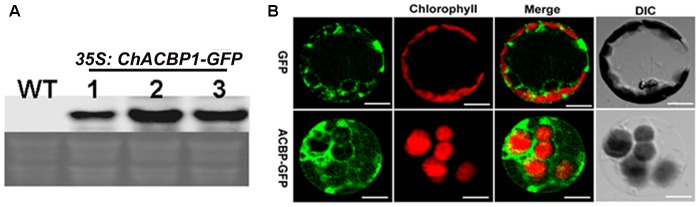
Subcellular localization of ChACBP1 in Arabidopsis protoplasts. (A) Northern blot analysis with ChACBP1 cDNA probe in three independent pBI121-ChACBP1-GFP transgenic lines (lanes 1–3). WT, Wild type. (B) Confocal microscope images of protoplasts of Arabidopsis pBI121-ChACBP1-GFP line 2 indicating localization of ChACBP1-GFP in the cytosol. GFP empty vector is shown at the top. Bars = 20 μm.